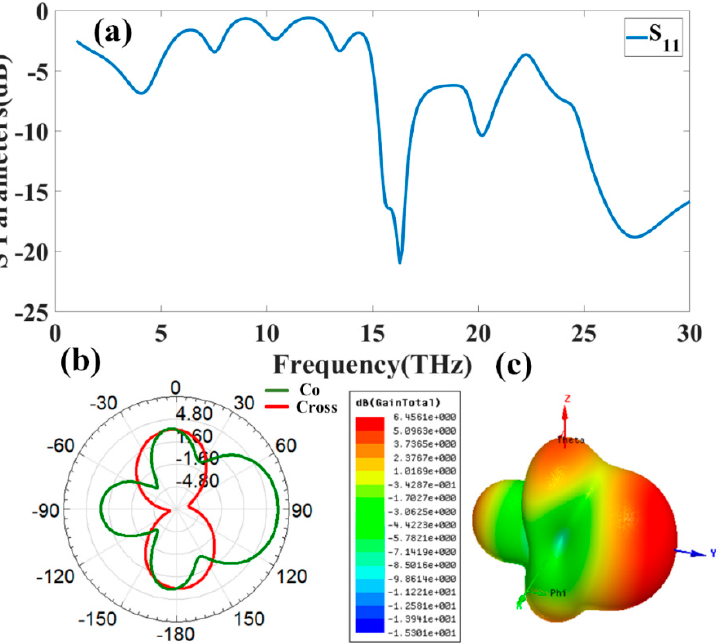
Figure A4. ( a ) Variations in S-parameters (S11) for the structure were all circular patched structures in a one-sided (Type-5) antenna. Calculated directivity in ( b ) 2D (with co- and cross-polarization) and ( c ) 3D, with a maximum directivity of 6.45 dB.